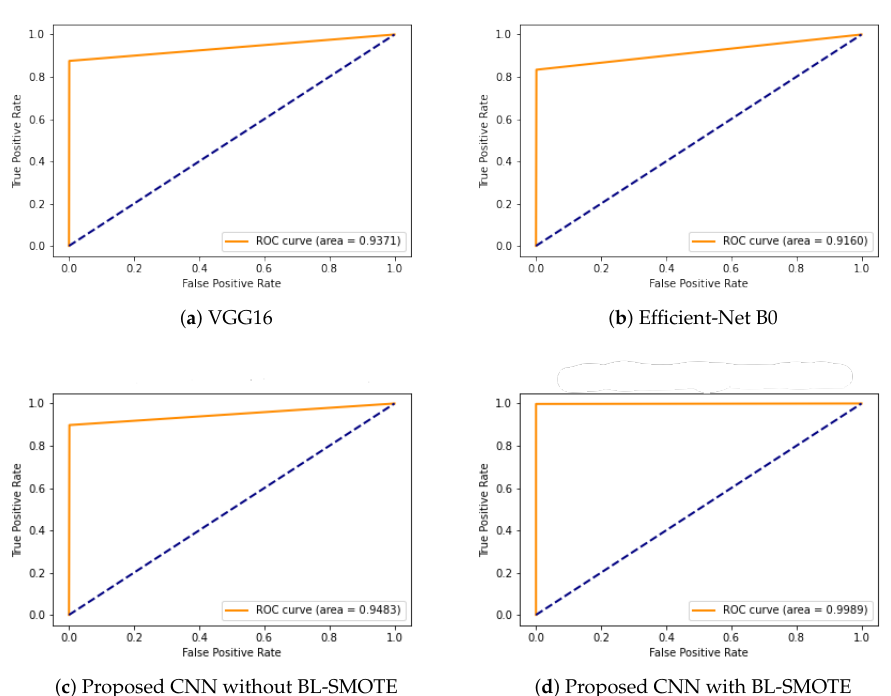
Figure 13. The ROC curve to compare the performance of ( a ) VGG16, ( b ) Efficient-Net B0, and ( c , d ) proposed deep CNN model with and without